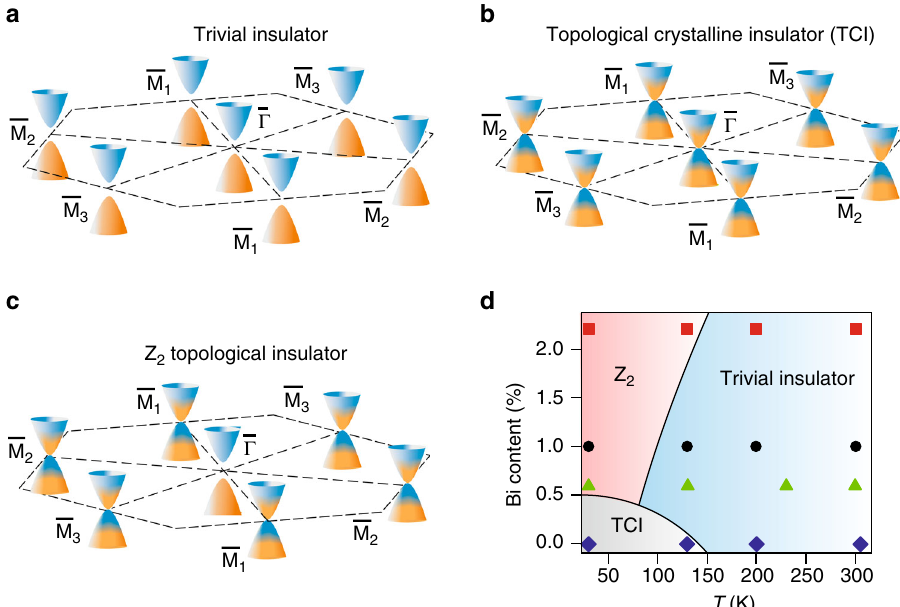
Fig. 4 Topological phase transition as a function of Bi doping and temperature. Schematic illustration of the transition from ( a ) trivial to ( b ) topological crystalline insulator (TCI) and eventually to ( c ) strong Z 2 topological insulator. d Topological phase diagram derived from our ARPES data for x Sn = 28%. The phase diagram contains a trivial phase at high temperature (positive gap Δ at all four L -points) with massive gapped cones at Γ and M ; a TCI phase at low temperature with even Z 2 invariant (all bulk L -points have negative, i.e., inverted gaps) and closed Dirac cones at Γ and all M points; a Z 2 topological insulator phase with odd Z 2 invariant due to a distortion along [111], giving three closed Dirac cones at the M points and an open gap at the Γ